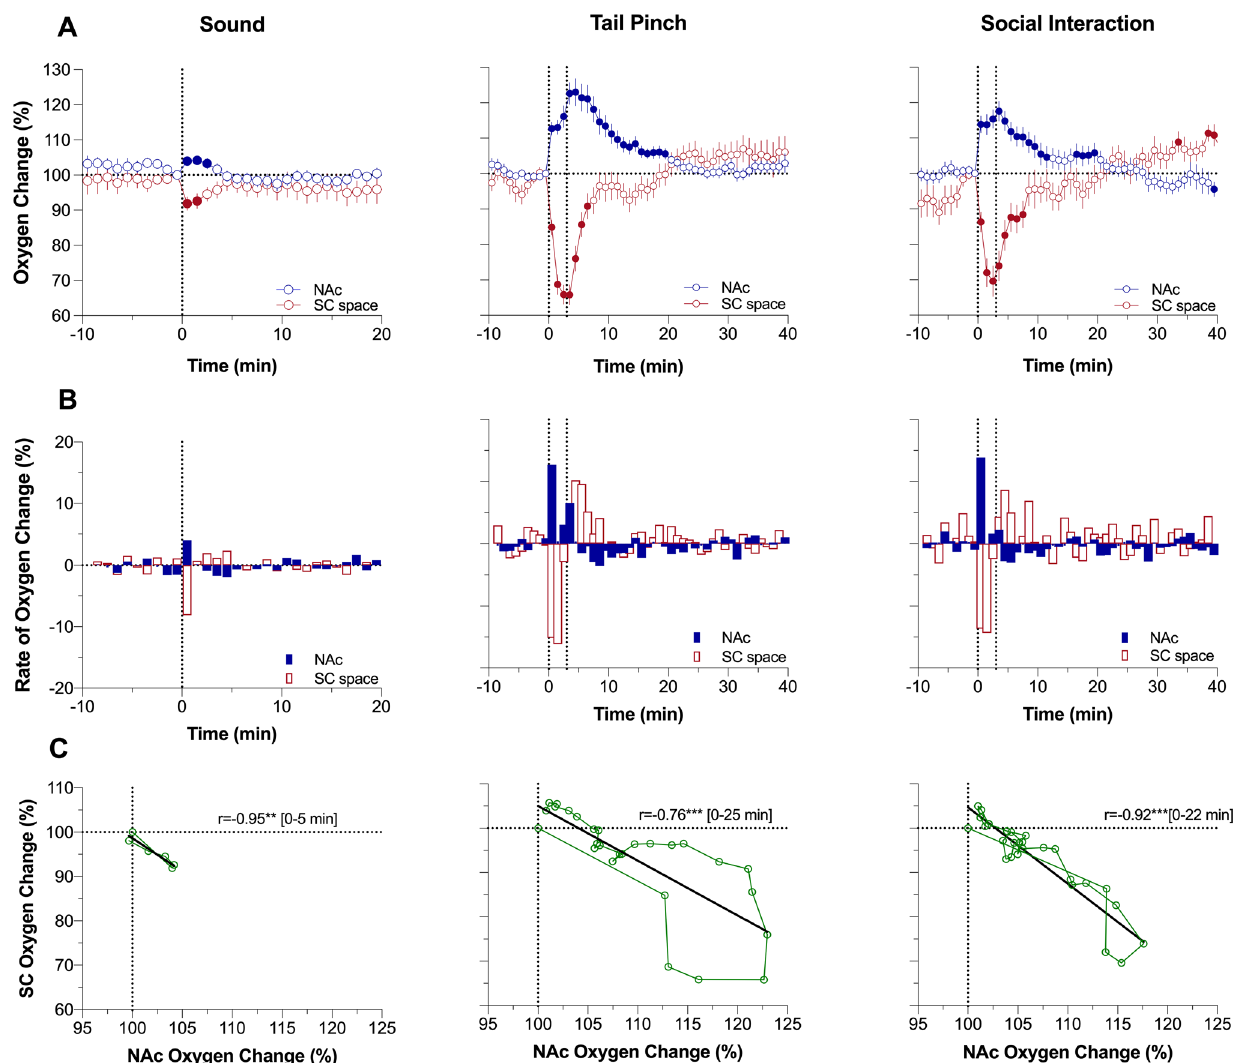
Figure 1. Relationship between changes in oxygen levels in the nucleus accumbens (NAc) and subcutaneous (SC) space induced by auditory stimulus (Sound), Tail-pinch and Social Interaction in awake, freely moving rats. Slow time-course analysis. ( A ) Mean (± SEM) changes in oxygen levels relative to baseline (100%) calculated with 1-min time bins. Vertical hatched lines show onset and offset of stimulus presentation. Filled symbols mark values significantly different from pre-stimulus baseline ( P < 0.05). ( B ) Rate of oxygen changes. ( C ) Correlative relationships between oxygen changes in two recording locations. r = coefficient of correlation calculated for the time interval of significant increase in NAc oxygen levels. Asterisks show significance of coefficients of correlation (** and ***, P < 0.01 and 0.001, respectively). Data were obtained in 6 rats; the numbers of averaged responses in each group are 9–16 (see Table for ANOVA values and n in each group in Supplementary